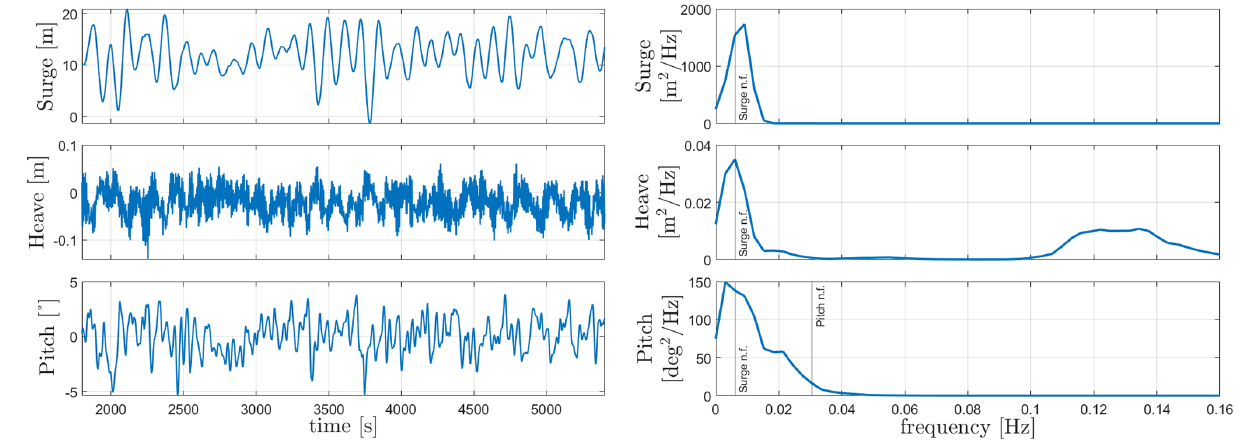
Figure 14. Activefloat response to ETM wind and NSS ( T p = 6s ,H s = 2m).